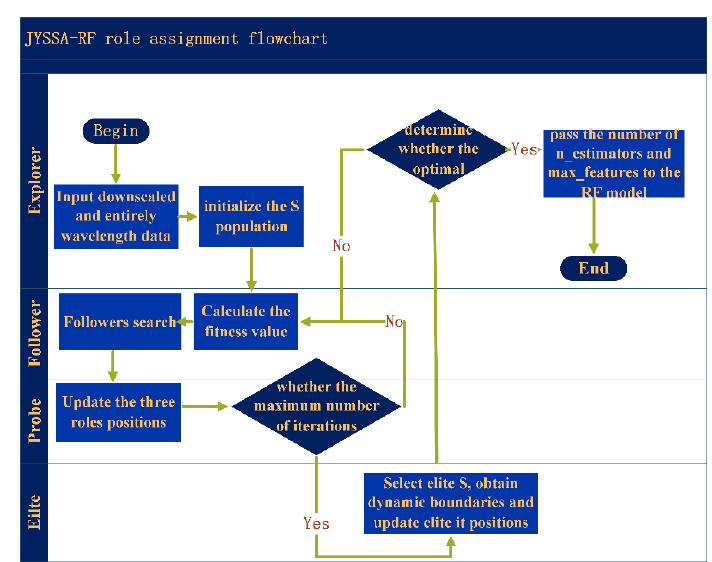
Figure 5. JYSSA algorithm procedures.